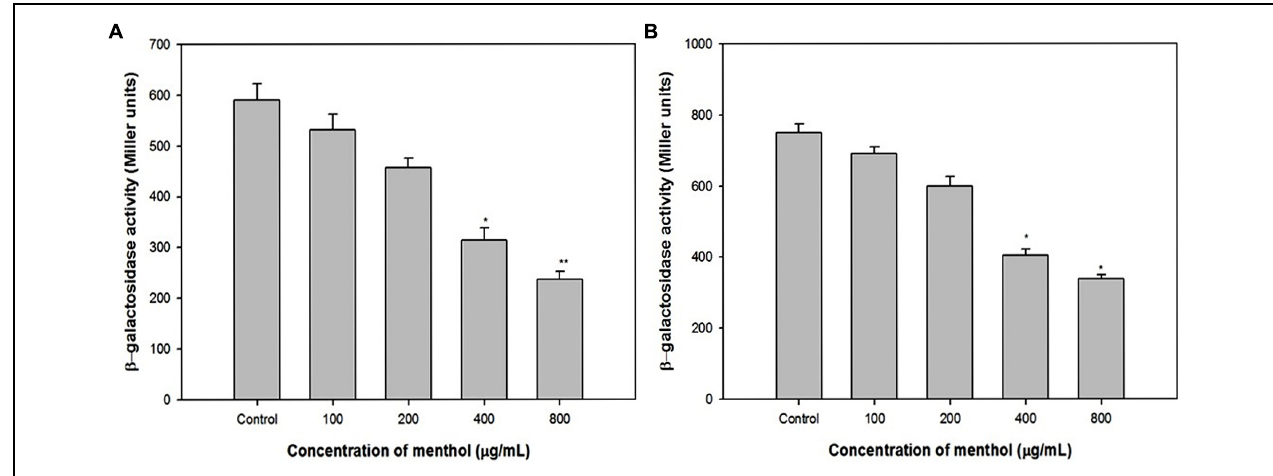
FIGURE 6 | Effect of menthol on las and pqs systems. (A) β -Galactosidase activity was measured in the E. coli MG4/pKDT17 with and without sub-MICs of menthol. (B) β -Galactosidase activity was measured in the E. coli pEAL08-2 with and without menthol. All of the data are presented as mean ± SD. Significance at ∗ p ≤ 0.05, significance at ∗∗ p ≤ 0.005.